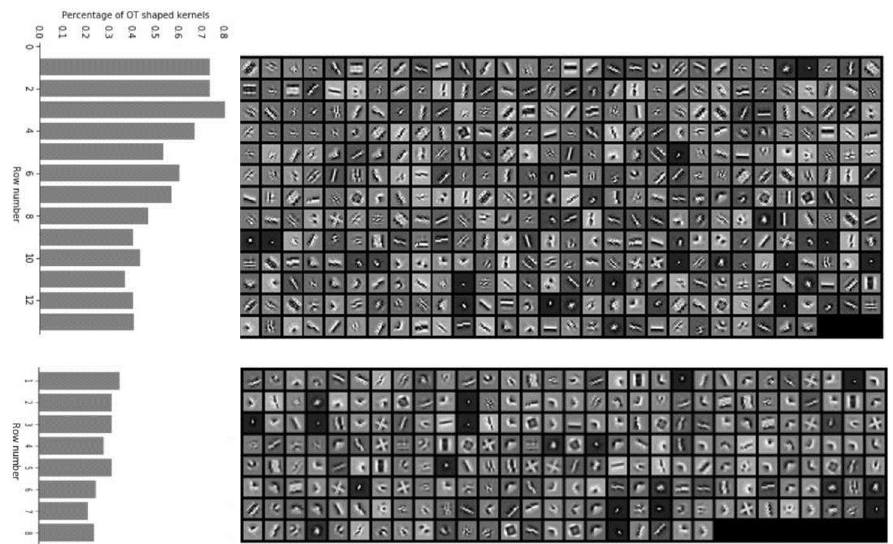
Fig 11. Classification of OT and HO neurons. The figure shows the RF recovered by the CMPR algorithm for all 387 OT neurons and 232 HO neurons. The order is ranked by score, as described in Eq 3, in increasing order. Along the left margin, the proportion of each row with simple orientation kernels selected by CMPR is shown, clearly decreasing as the score increases, showing a correspondence between these metrics of HO tuning.